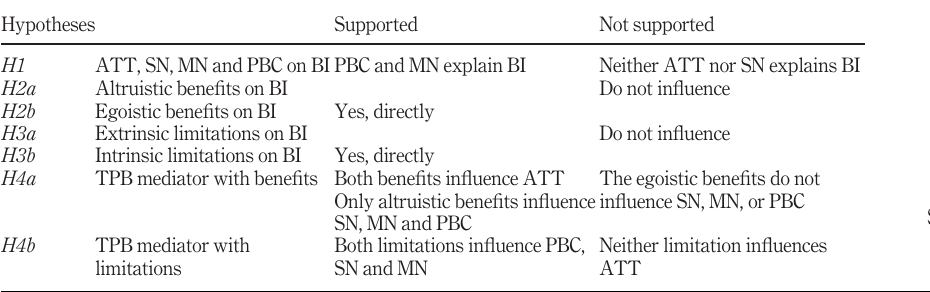
Table 4. Summary of